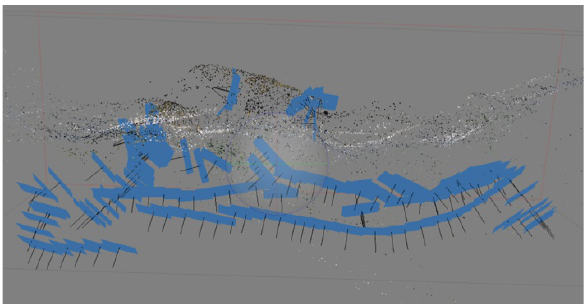
Figure 13. Shooting